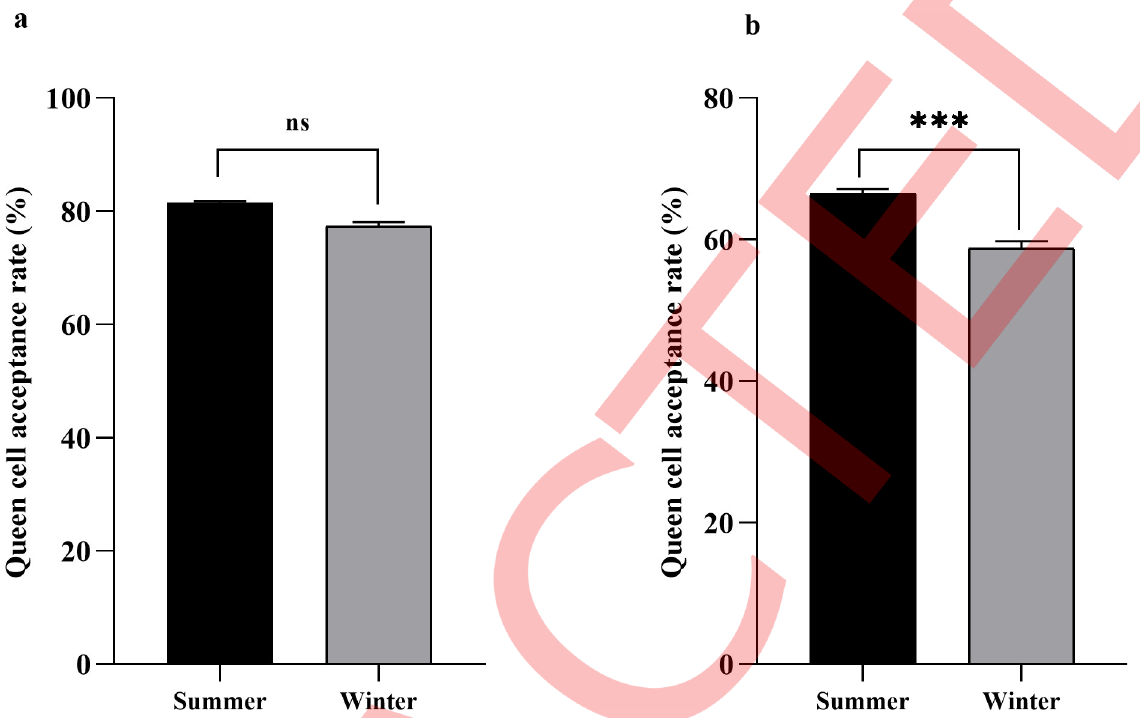
Fig 7. The effect of various season on queen cell acceptance rate (shows as mean ± SE) between Italian and Carniolan colonies. “ ��� ” represents statistically significant differences (Student’s t -test, p < 0.05).